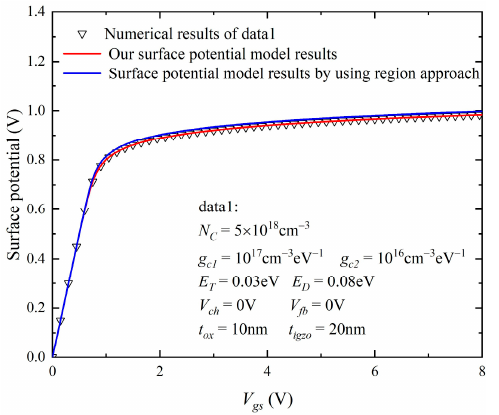
Figure 4. Comparisons of surface potential results between our model, regional approach and numerical results using data1.